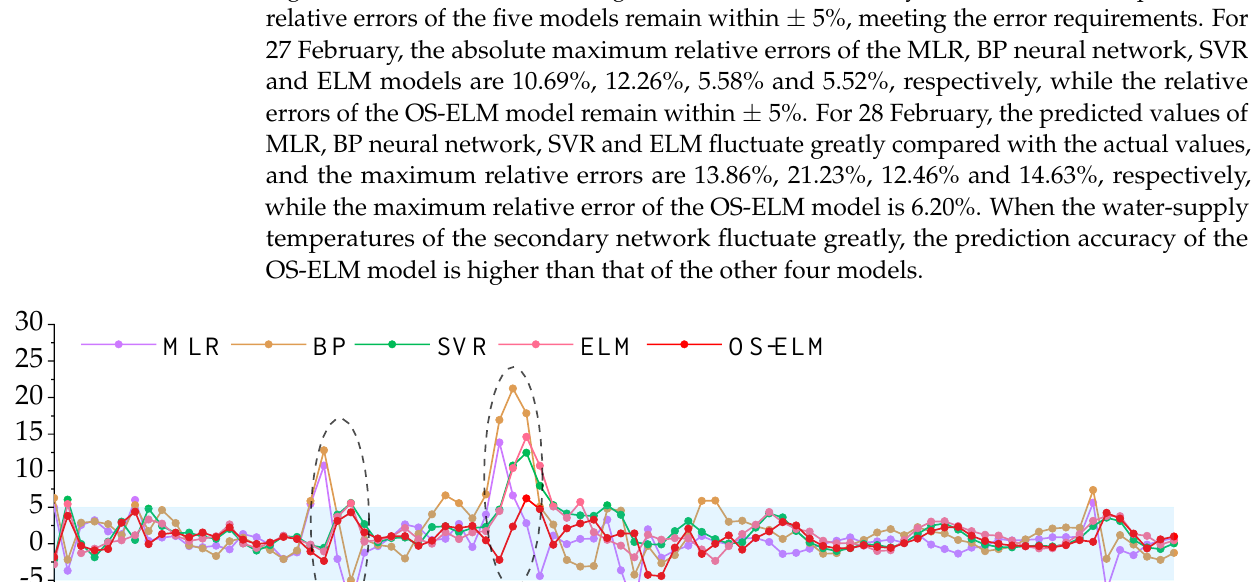
Figure 9. Comparison of the predicted values and actual values of the five models on feature set M.